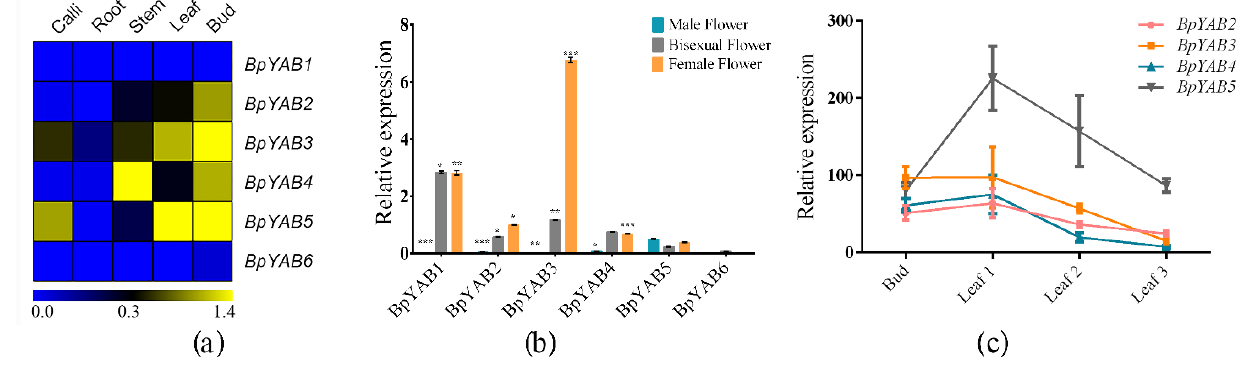
Figure 4. The expression patterns of BpYAB genes in different tissues. ( a ) The expression pattern of BpYAB genes in the callus, leaf, bud, stem, and root at the transcription level. ( b ) The expression levels of BpYAB genes in the female flower, male flower, and bisexual flower. * means p less than 0.05, ** represents p < 0.01 and *** represent p < 0. 001.Transcript levels of ( a ) and ( b ) were determined by qRT-PCR with three independent biological replications, and the expression of BpGAPDH was used as an internal control. ( c ) The expression levels (values of FPKM) of four BpYAB genes in the apical bud and leaf at three developmental stages. Leaf 1 is the newly grown leaf, visible to the human eye; Leaf 2 is the tender leaf; and Leaf 3 is the mature leaf. The data were obtained from the transcriptome of the paper mulberry.